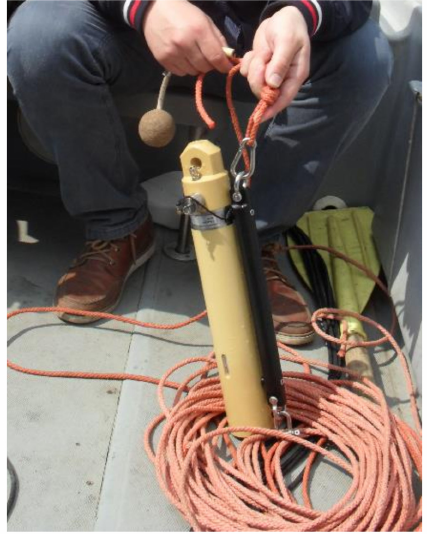
Figure 3. STD/CTD probe model